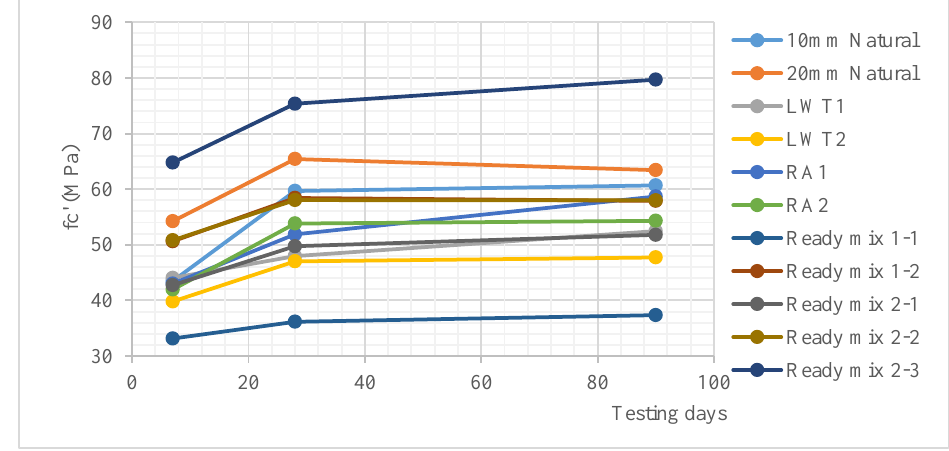
Figure 4. Average cylinder compressive strength.